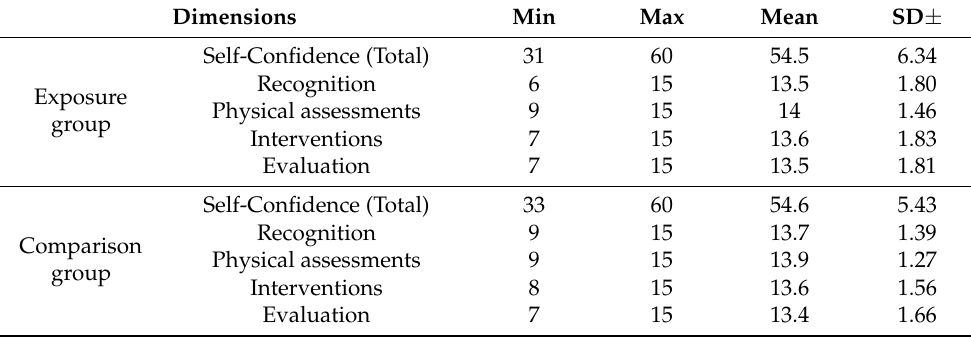
Table 3. Nurses’ self-confidence and its subdimensions’ scores.